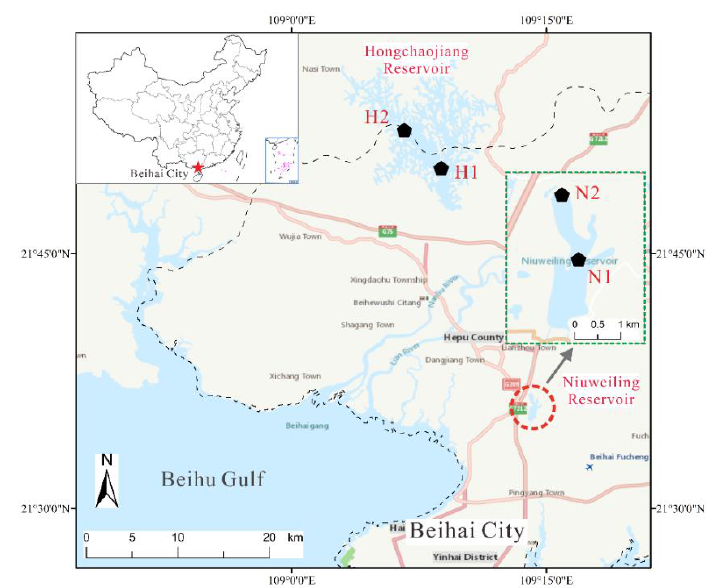
Figure 1. Location of the Hongchaojiang and Niuweiling reservoirs in Beihai City, southern China, and the sampling sites (black pentagons).